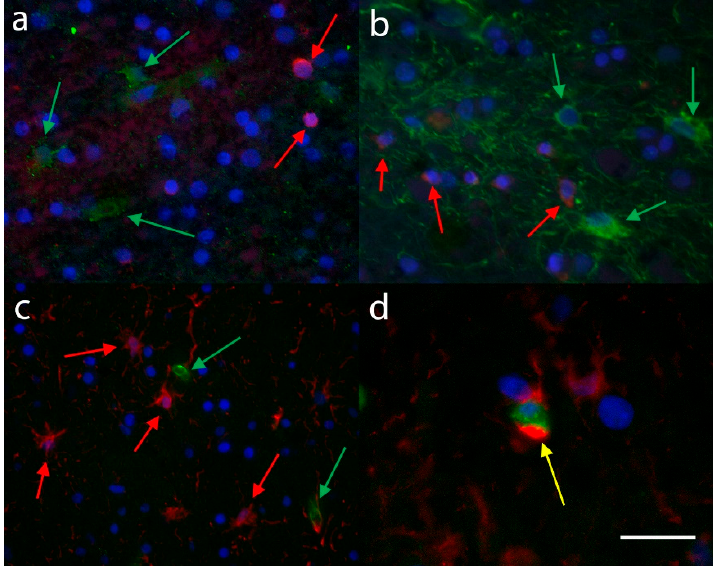
Figure 9. The double immunofluorescence in AD cases revealed ( a ) the C3 immunopositive ASLCs (red, arrows) to be a different population from the S100A10 immunopositive ASLCs (green, arrows) with no cells showing co-localisation. In ( b ) there appeared to be no co-localisation between the C3 immunopositive ASLCs (red, arrows) and the GFAP immunopositive ASLCs (green, arrows). Whereas many of the S100A10 immunopositive ASCLs (green, arrows) did not co-localise with GFAP immunopositive ASLCs (red, arrows) ( c ), there were a number of ASLCs that did co-localise ( d , arrow). Scale Bar ( a ), ( b ) − 50 µm, ( c ) − 75 µm, ( d ) − 25 µm.